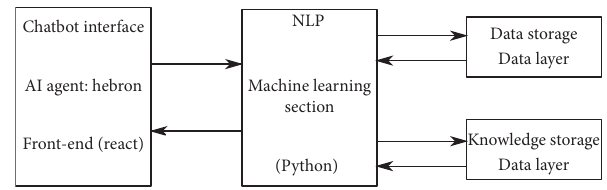
Figure 1: Block diagram for the University Chatbot